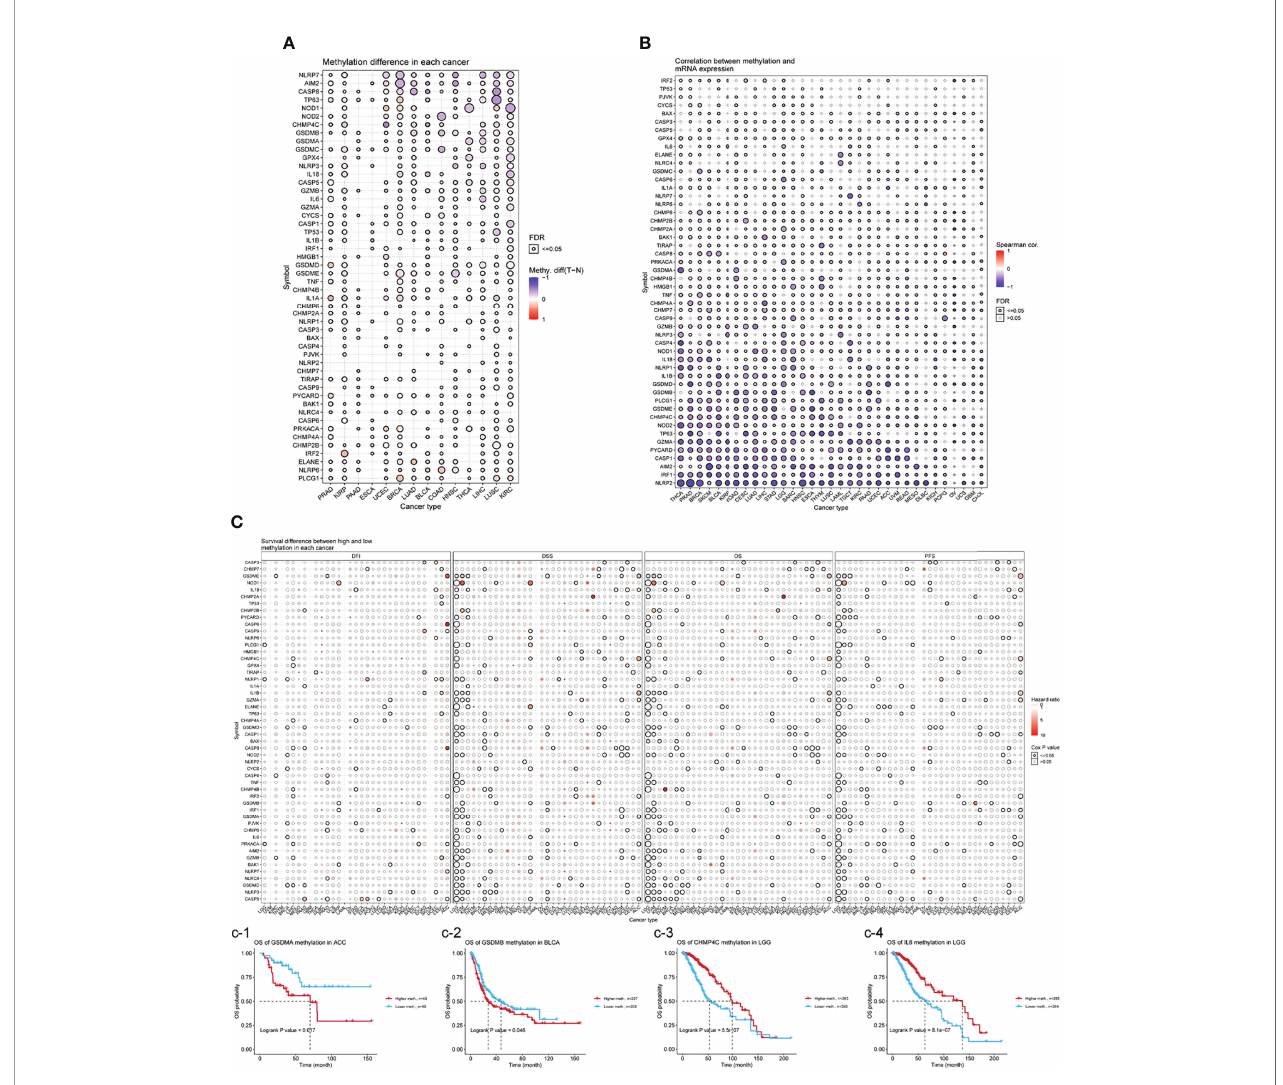
FIGURE 6 | (A) Differential methylation in necroptosis-related genes between tumor (T) and normal (N) samples in each cancer. Red dots represent increased methylation in tumors and blue dots represent decreased methylation in tumors. The darker the dot color, the larger the difference in methylation level. (B) Correlations between methylation and mRNA levels of genes in speci fi c cancers. Red points represent a positive correlation, and blue dots represent a negative orrelation. The size of the point represents the statistical signi fi cance, where the bigger the dot size, the higher the statistical signi fi cance. FDR, false discovery rate. (C) Survival difference between necroptosis-related genes with high and low methylation levels and samples. Red dots represent worse survival of the hypermethylation group; blue dots represent the opposite. The dot size represents the statistical signi fi cance, the larger the dot size means, the higher the statistical signi fi